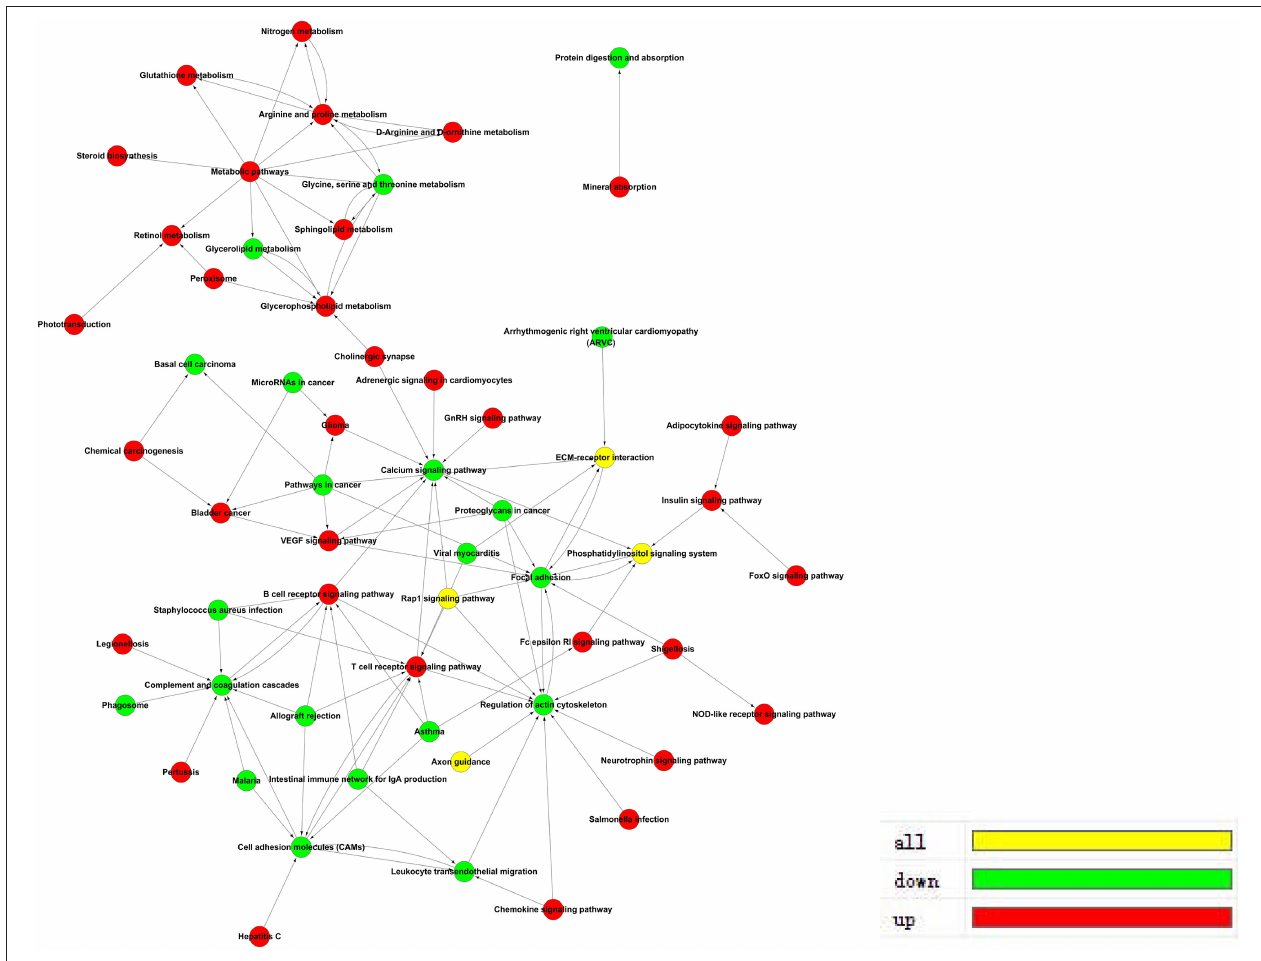
FIGURE 6 | Pathway-Act network in ACADSB − / −